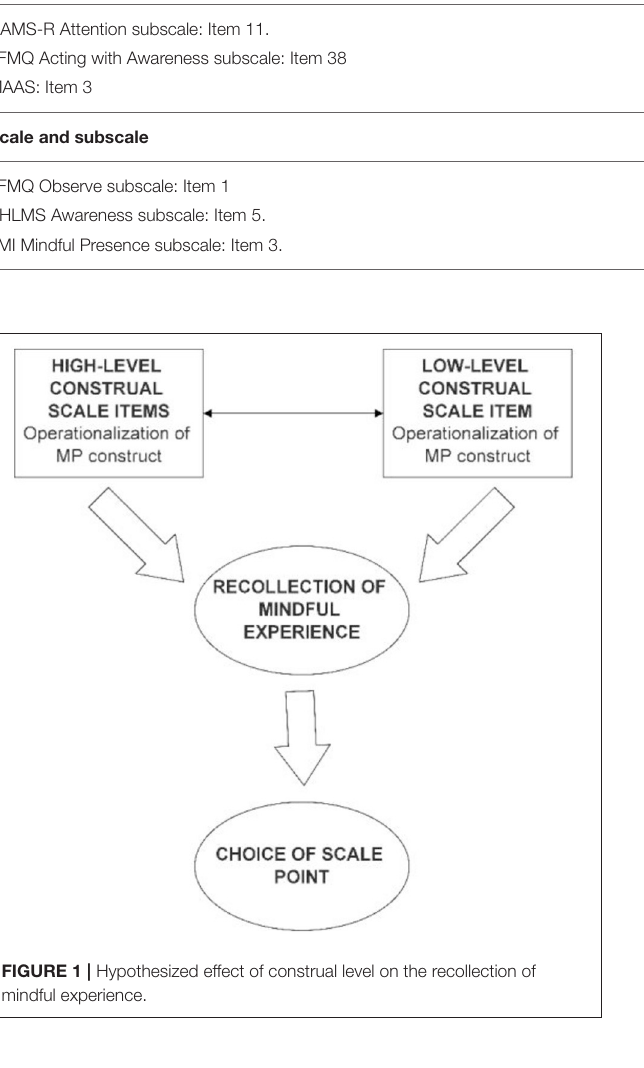
TABLE 1 | Relevant sample items from scales used in the validation process. Scale and subscale